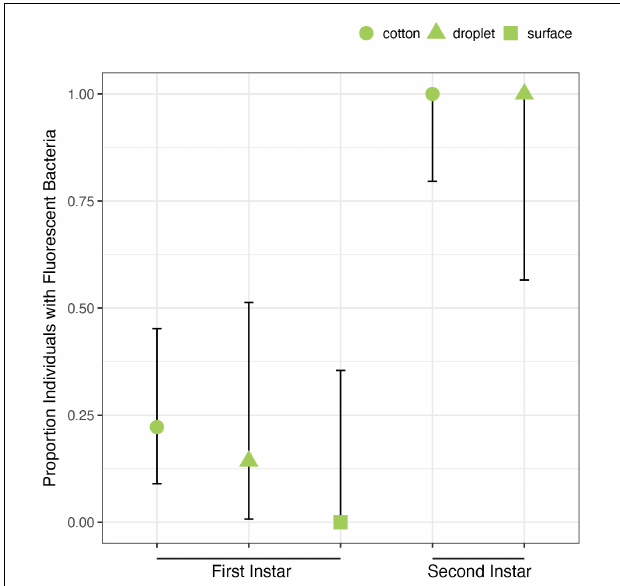
FIGURE 5 | Acquisition of Caballeronia is largely constrained to later instars. Using three feeding methods (“cotton,” “droplet,” and “surface”) in which squash bugs were exposed to solutions containing high concentrations of Caballeronia sp. SQ4a, first instars ( n = 27) only rarely established infections. In comparison, when second instars ( n = 20) were fed using two of the three methods, they always established the symbiosis. Error bars are binomial confidence intervals.